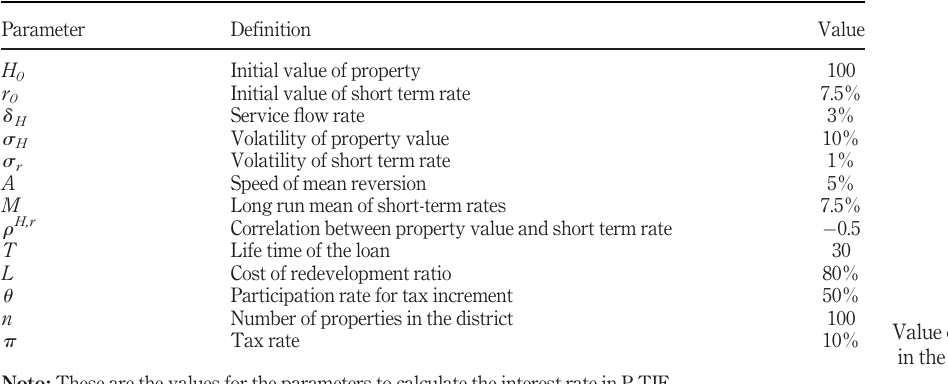
Table I. Value of